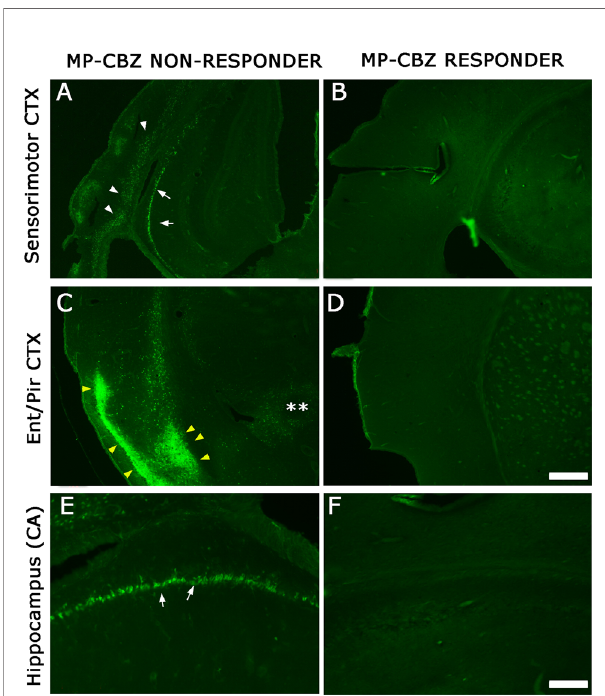
FIGURE 3 | FJ labeling in neocortical and hippocampal areas in MP-CBZ/ non-responders and MP-CBZ/responders. FJ staining of representative MP- CBZ/non-responder (A , C , E) and MP-CBZ/responder rat (B , D , F) in the frontoparietal sensorimotor (A, B) , and entorhinal (C, D) cortical areas, and in the hippocampus (E, F) . Note the numerous FJ + neurons in all neocortical areas in MP-CBZ/non-responder when compared to MP-CBZ/responder rats. FJ + degenerating neurons were found in deep cortical layers of sensorimotor cortex (white arrowheads, (A) of MP-CBZ/non-responder rats, paralleled by diffused necrotic areas at the entorhinal/piriform cortical area (yellow arrowheads in (C) . At the hippocampal level many FJ positive neurons were detected in CA1/2 regions of MP-CBZ/non-responder rats (arrows in A , E ). By contrary, FJ + degenerating neurons were never found in MP-CBZ/ responder rats in any region considered (2 out of 8; B , D , F ). Scale-bars: 300 m m in A-D; 100 m m in